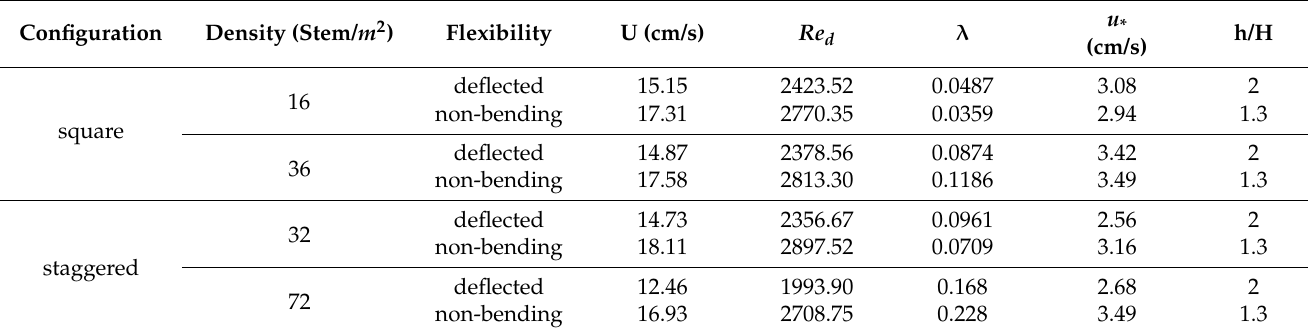
Table 2. Some data for the flow depth of 20